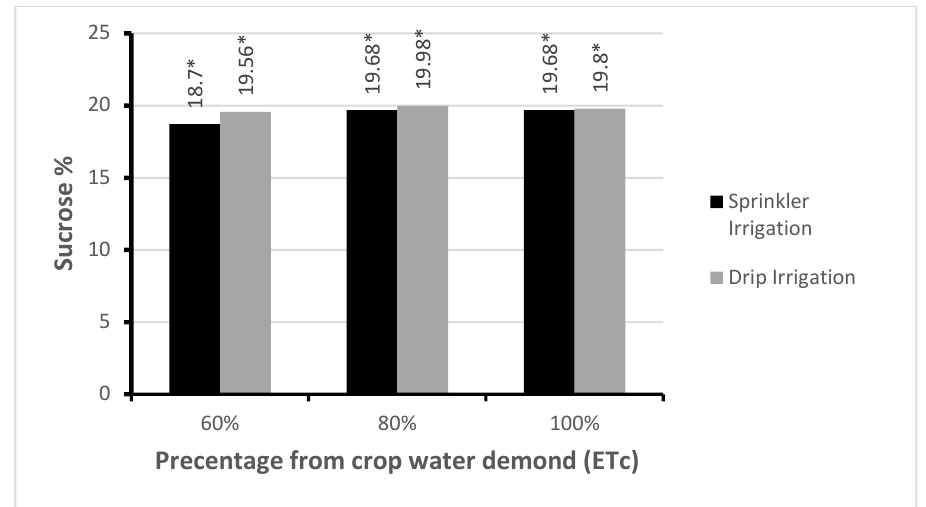
Figure 7. Date palm sucrose (%) under different irrigation systems with different regimes. Significant differences *, Non-significant **, (ha): Hectare, WP: Water productivity, M 3 : Quebec meter.